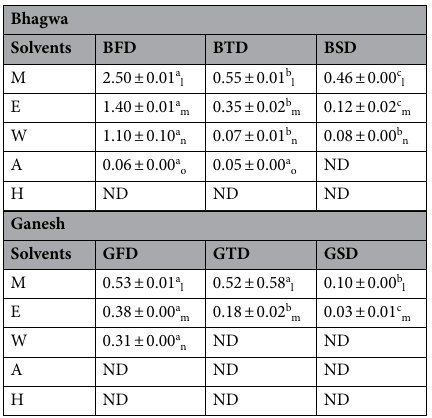
Table 5. Quantification of Quercetin (mg/g) compounds from pomegranate peel extract. Mean ± SD n = 3, a, b, c represents a statistically significant difference between drying methods in row wise manner for specific solvent whereas l, m, n, o, p, q refers to statistically significant difference among solvents for respective drying method (column wise); BFD Bhagwa freeze-dried, BTD Bhagwa tray-dried, BSD Bhagwa sun-dried, GFD